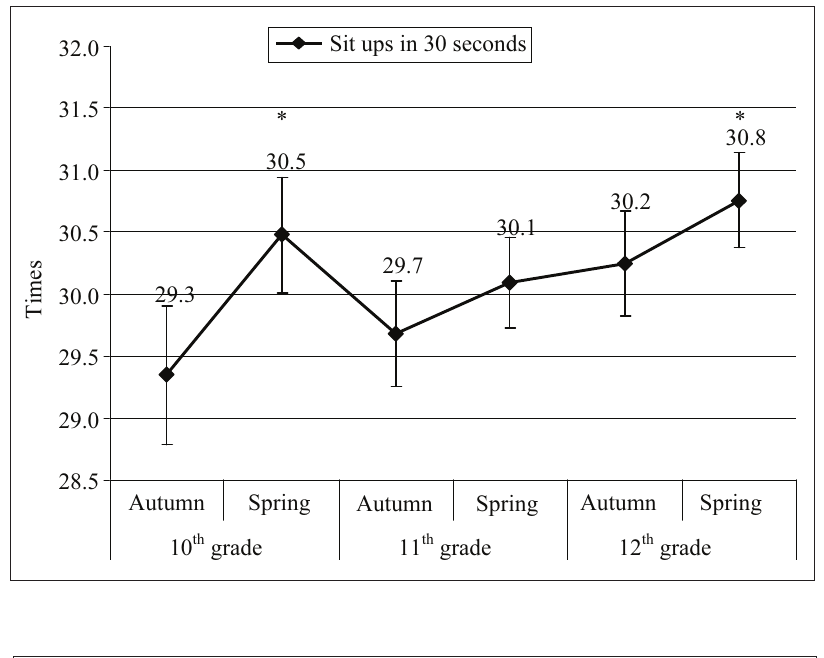
Figure 4. Comparison of changes in results in